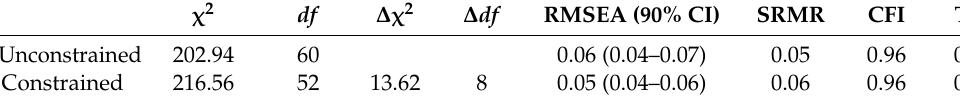
Table 4. Test of measurement invariance in male and female groups.